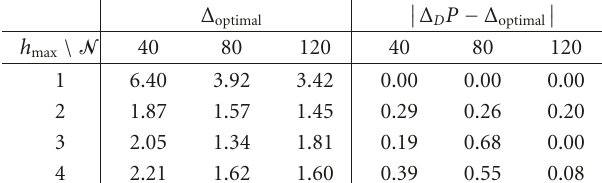
Table 4: Approximation error Δ using optimal algorithm for given h max and N , expressed in [%].